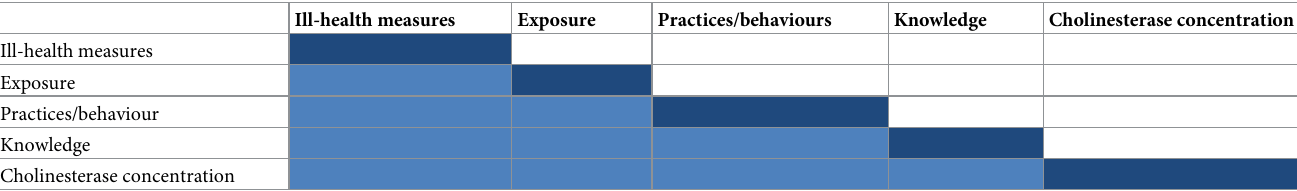
Table 1. Contingency tables for each